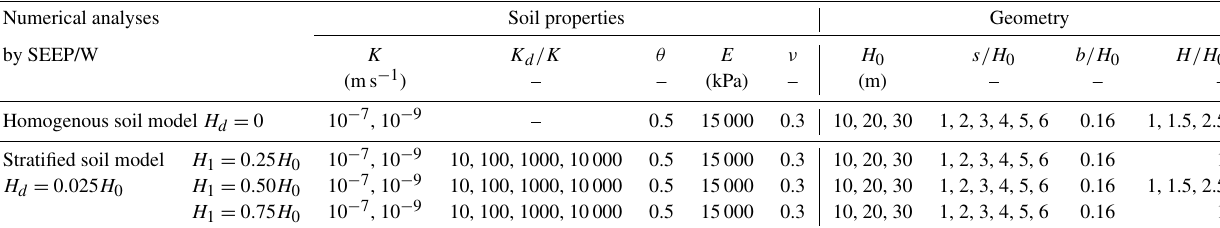
Figure 1. (a) Schematic representation of the case at hand. (b) Flow lines and equipotential lines in homogeneous soil; piezometric heads along the vertical axes at the middle of the trench, at the centre line between two adjacent trenches and on the horizontal plane at depth of trench bottom. (c) Scheme with an intermediate permeable layer. (d) Equivalent scheme with a water film at the depth of the uppermost boundary of layer d . Table 1. Examined cases studied with